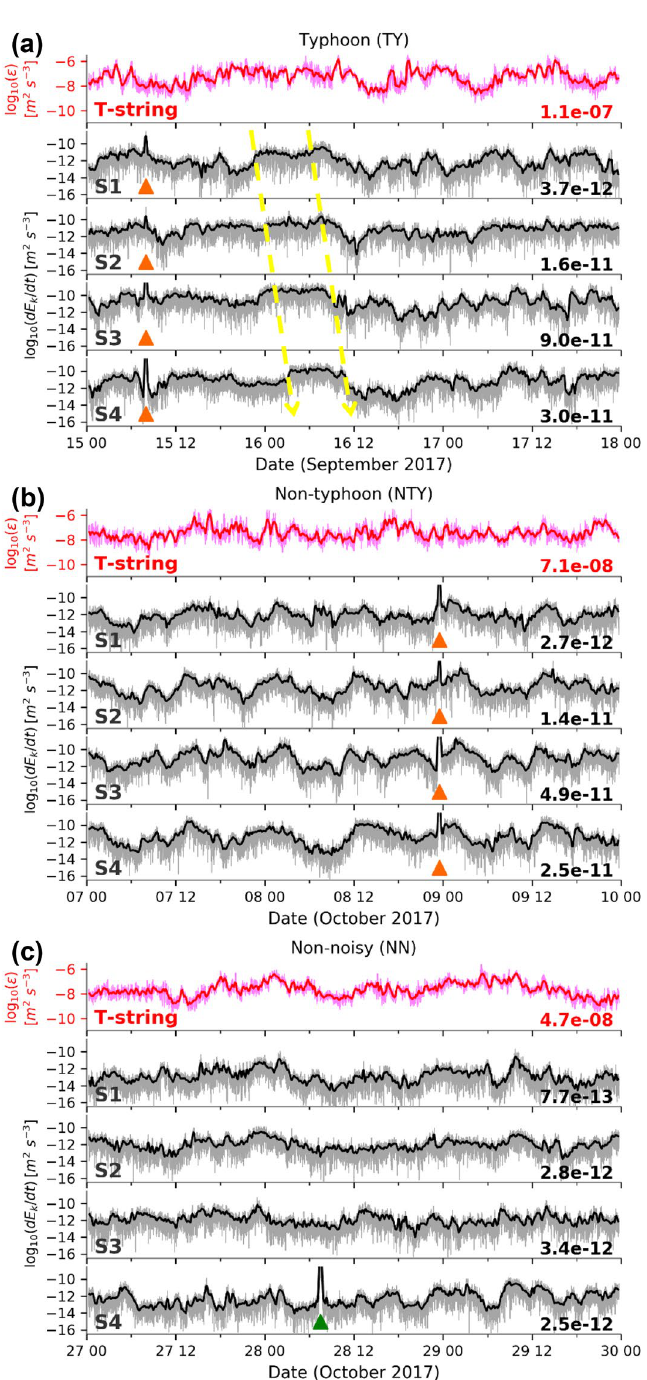
Figure 3. Three-day time series of vertically averaged over 200-m turbulent kinetic energy dissipation rate ( ε ) and the time derivative of kinetic energy (TDKE, dE k / dt ) calculated from T-string data and OBS velocity data, respectively, during: ( a ) Typhoon period (TY, September 15–17), ( b ) Non-typhoon period (NTY, October 7–9), and ( c ) Non-noisy period (NN, October 27–29) period. Dark and light lines in each panel show the raw and the 15-min time window (with half-window shifts) moving averaged time series, respectively. Orange and green triangles are the same as in Fig. 2e. The number at the bottom right of each panel is the time-averaged value of energy variations. Dashed yellow arrows show estimated horizontal apparent phase